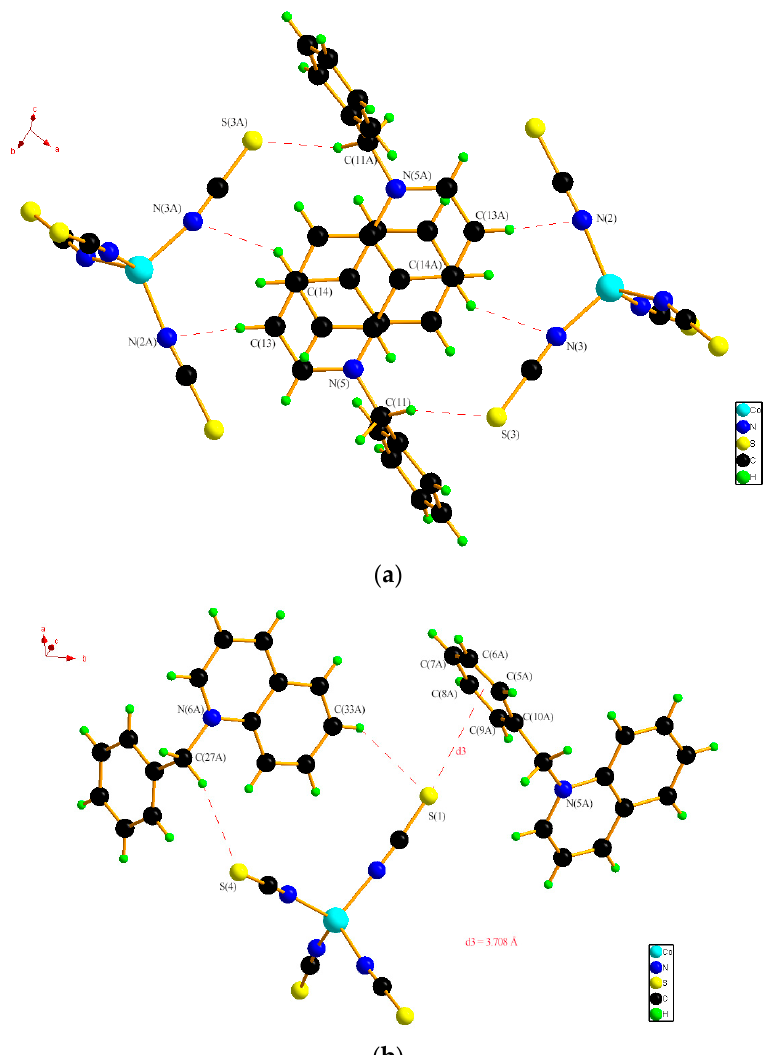
Figure 4. ( a ) The cationic dimers with two [Co(NCS) 4 ] 2 − anions formed an alliance through